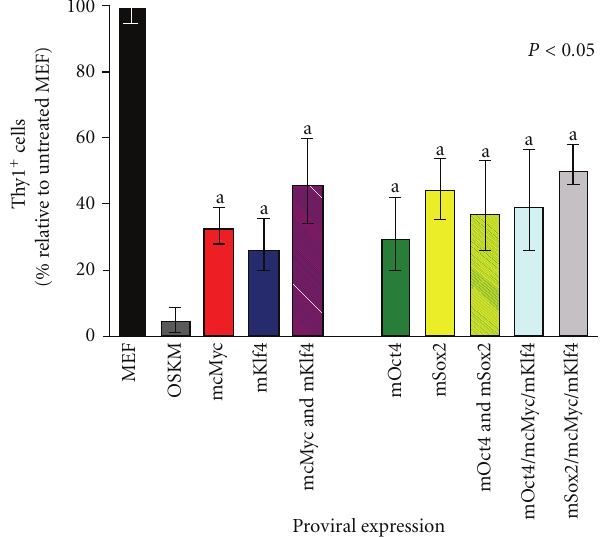
Figure 1: Contribution of individual reprogramming factors to repression of Thy1. MEFs were infected with either all four reprogramming factors (OSMK), individual reprogramming fac- tors (mOct4 or mSox2 or mcMyc, or mKlf4), or combinations of reprogramming factors (mcMyc & mKlf4, OS, OMK, SMK). On day 12 after infection, the percentage of cells expressing the fibroblast marker Thy1 was assessed by flow cytometry in all treatment groups. Mean percentage Thy1 + cells, normalized to untreated MEF controls (black bar) of n = 5 experiments ± SEM are shown. Statistical significance established by one-way ANOVA, with “a” denoting groups insignificantly di ff erent from each